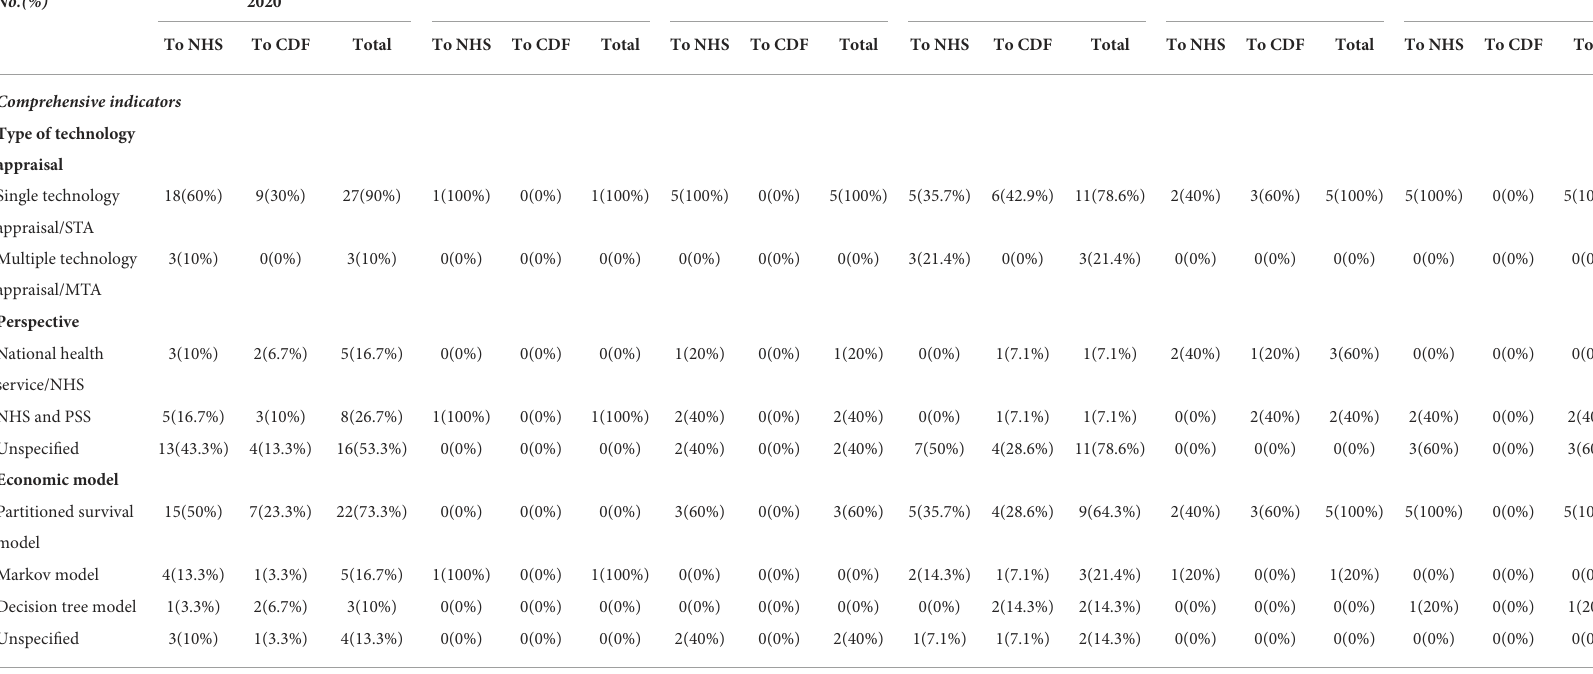
TABLE 2 Details of comprehensive indicators in guidance from 2016 to